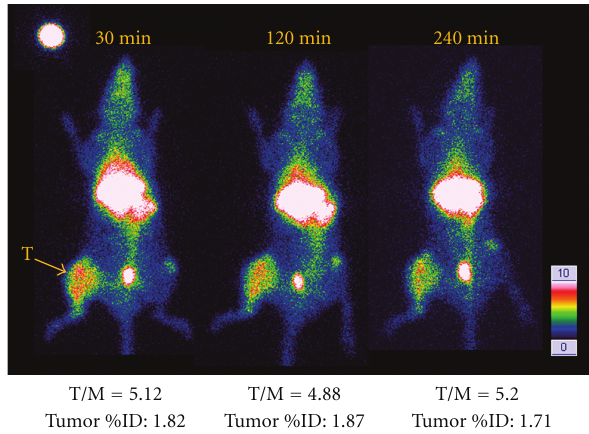
Figure 5: The selected planar scintigraphic images of breast tumor- bearing rats at 30, 120, and 240 minutes after 99m Tc-N4-Tyrosine injection (T indicates tumor; T/M, tumor-to-muscle ratio; tumor %ID, percent of injected dose in the